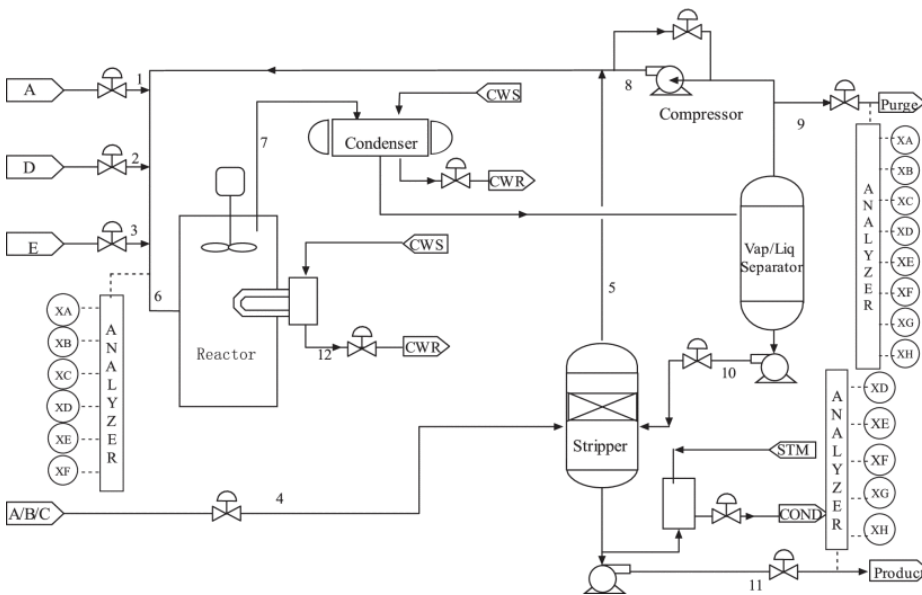
Figure 3. Graphical description of the TE